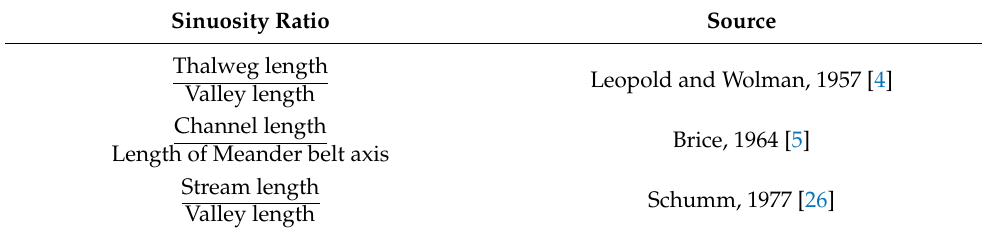
Table 1. Measurement of Sinuosity Ratio. Sinuosity Ratio Source Valley